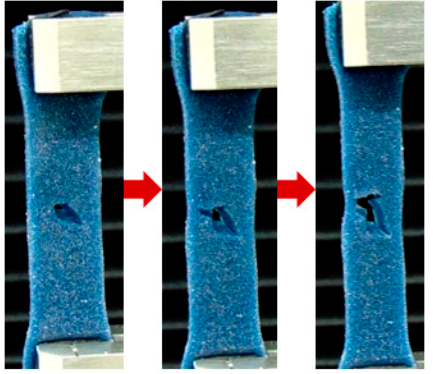
Figure 4. Mechanical tensile test of a wounded skin phantom used for DIC measurements.